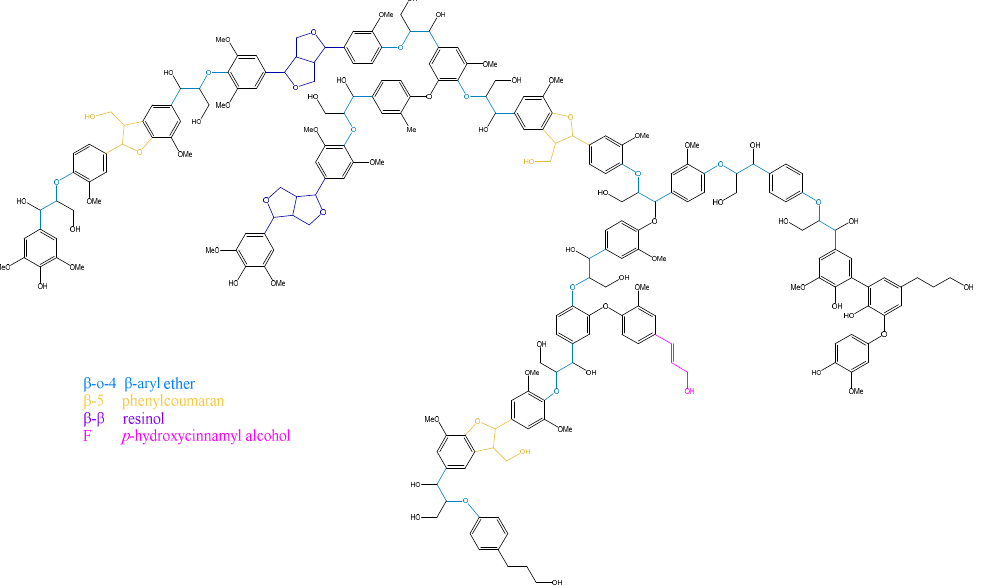
Molecules 2023 , 28 , 1513 Figure 8. The molecular structure model of AHMWL. Figure 8. The molecular structure model of AHMWL.